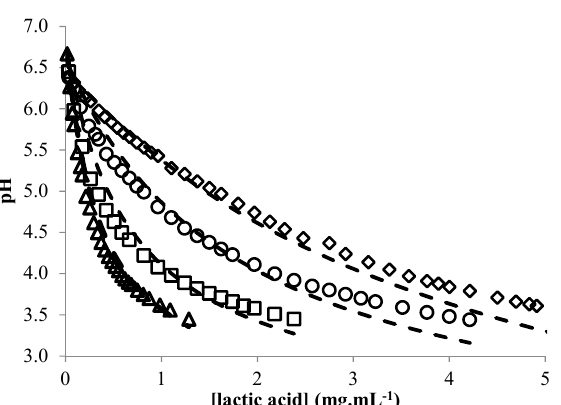
Figure 6. Changes in the experimental (symbols) and predicted (continuous lines) pH of sorghum flour dispersions ( , 0.4 g/ML; , 0.2 g/mL; , 0.08 g/mL; , 0.04 g/mL) with different lactic acid concentrations.